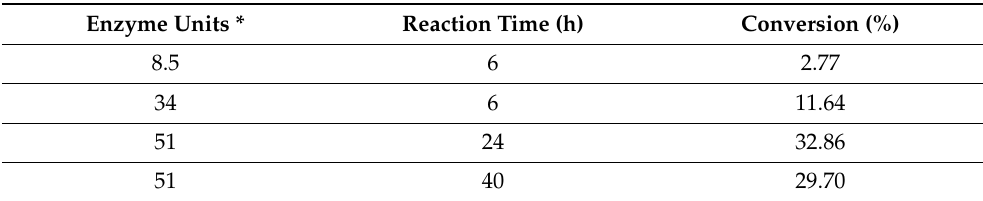
Table 4. Hydrolysis of ibuprofen methyl ester to S -ibuprofen with KLEST-3S varying enzyme amount during time. Cosolvent, 10% ( v / v ) DMF; temperature, 65 °C .